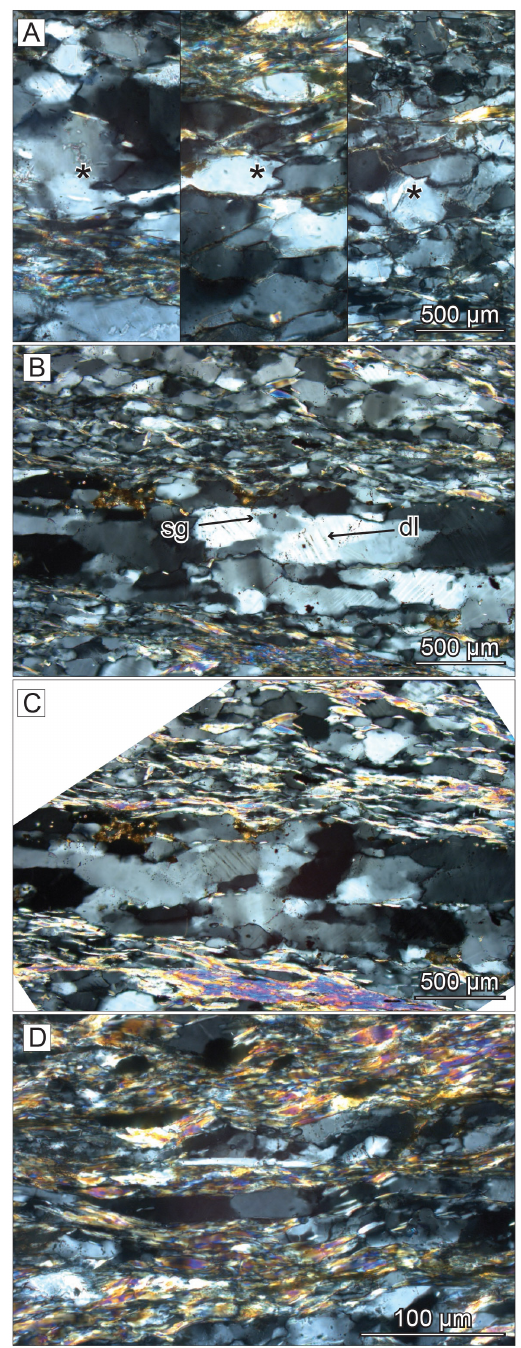
Figure 3. Quartz microtextures observed in thin sections. All pho- tomicrographs are cross polarized light. (a) Three examples of mi- nor bulging recrystallization. (b) Subgrain development within the quartz-rich lens. Also visible are deformation lamellae. (c) Same lo- cation as in (b) with the stage rotated to further highlight subgrain formation. (d) A matrix quartz grain (centre) encased by phyllosili-